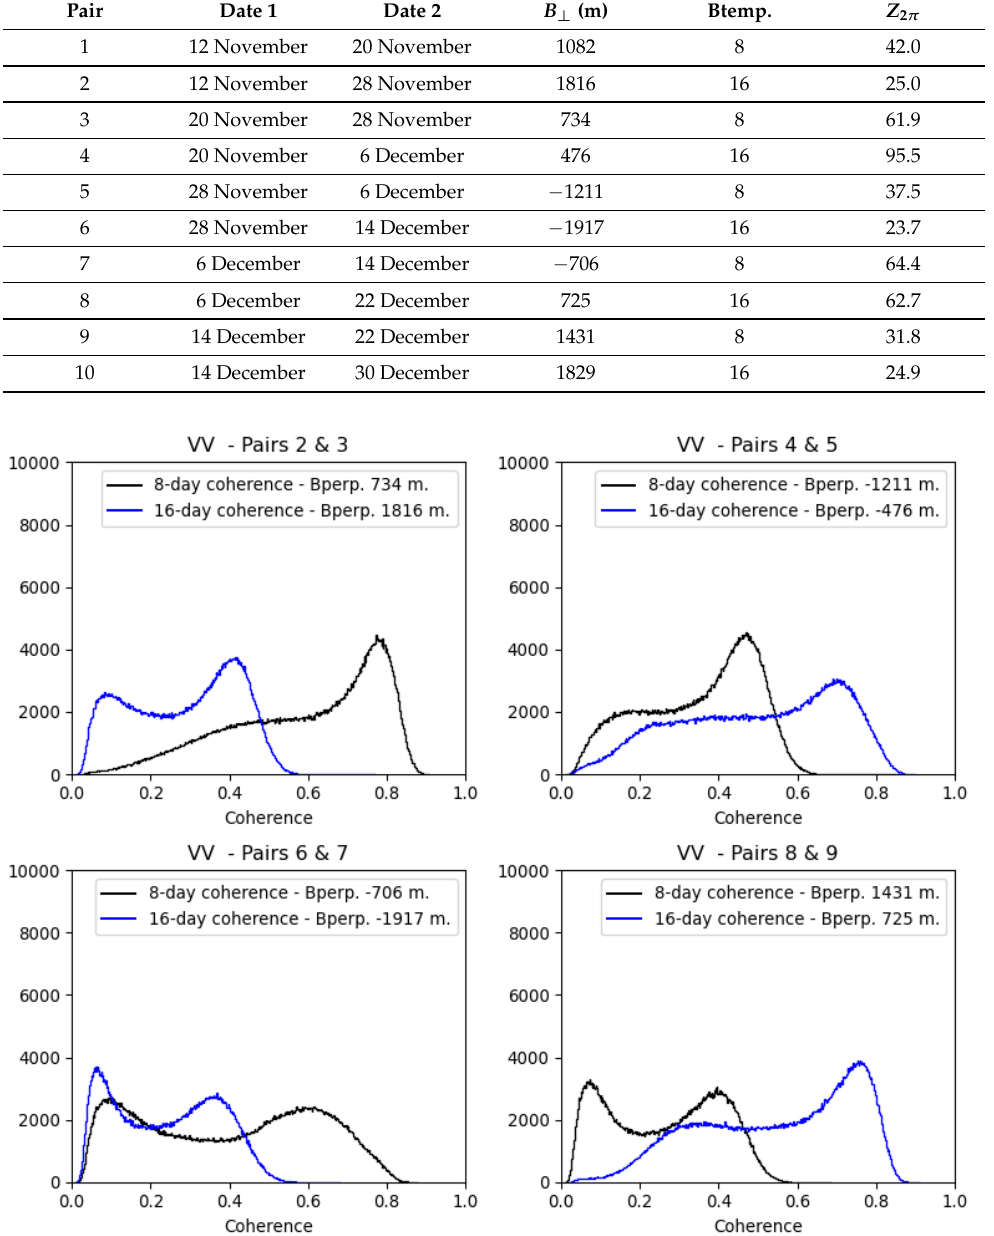
Figure 9. | γ VV | histograms for SAOCOM-1 8-day and 16-day pairs chosen from Table